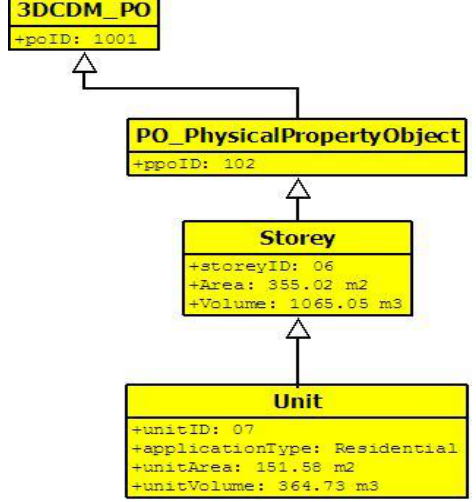
Figure 18. Instance of PO_PhysicalPropertyObject association of 3DCDM_PO Package